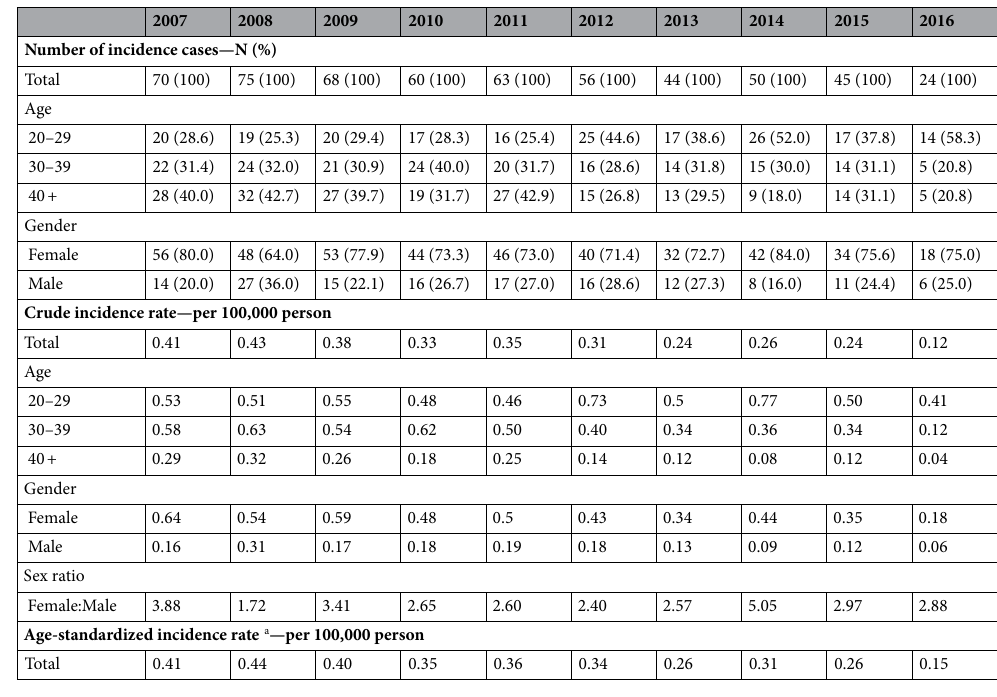
Table 2. Incidence of multiple sclerosis in Taiwan. a According to WHO 2000–2025 standard